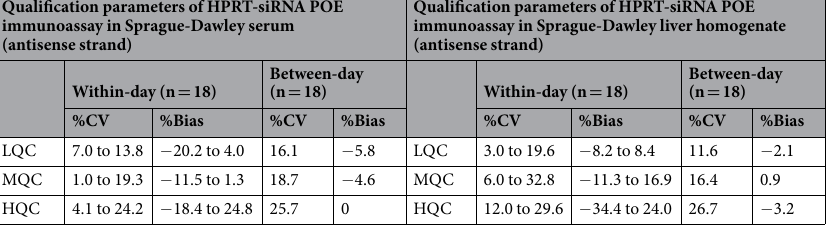
Table 1. Accuracy and precision results within-day and between-days for the qualification of HPRT.siRNA antisense POE immunoassay in Sprague-Dawley serum and liver tissue